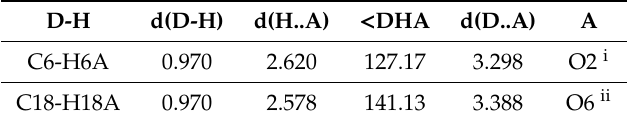
Table 2. Geometric parameters (Å, degree) for C-H ... O